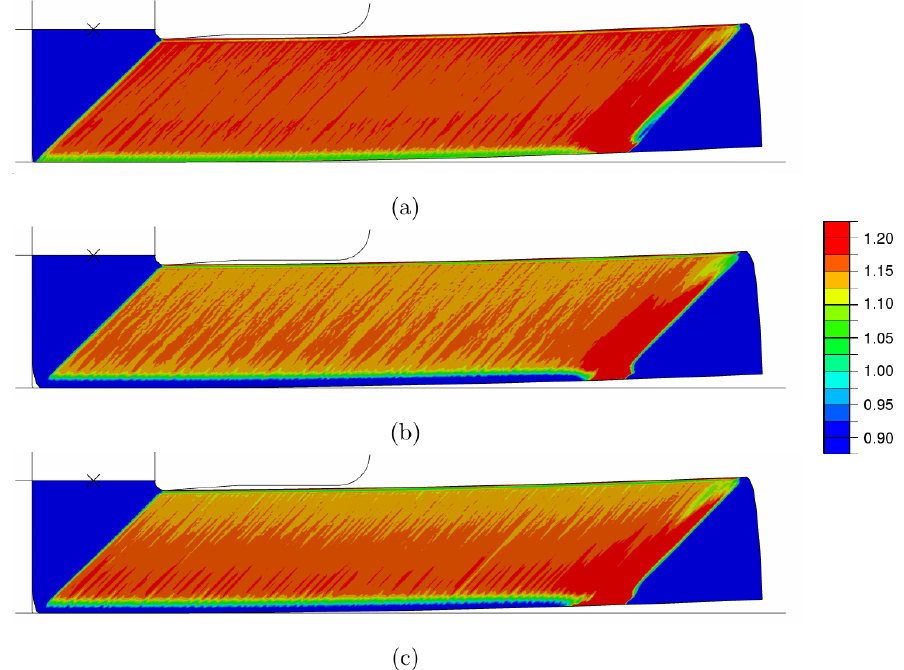
Figure 5. Effective plastic strain s (cf. Equation (9)) for simulations with isotropic hardening with γ = 15 MPa in combination with ( a ) β = 0.1, ( b ) β = 1.0 and ( c ) β = 10.0. σ β only minor fluctuations occur.